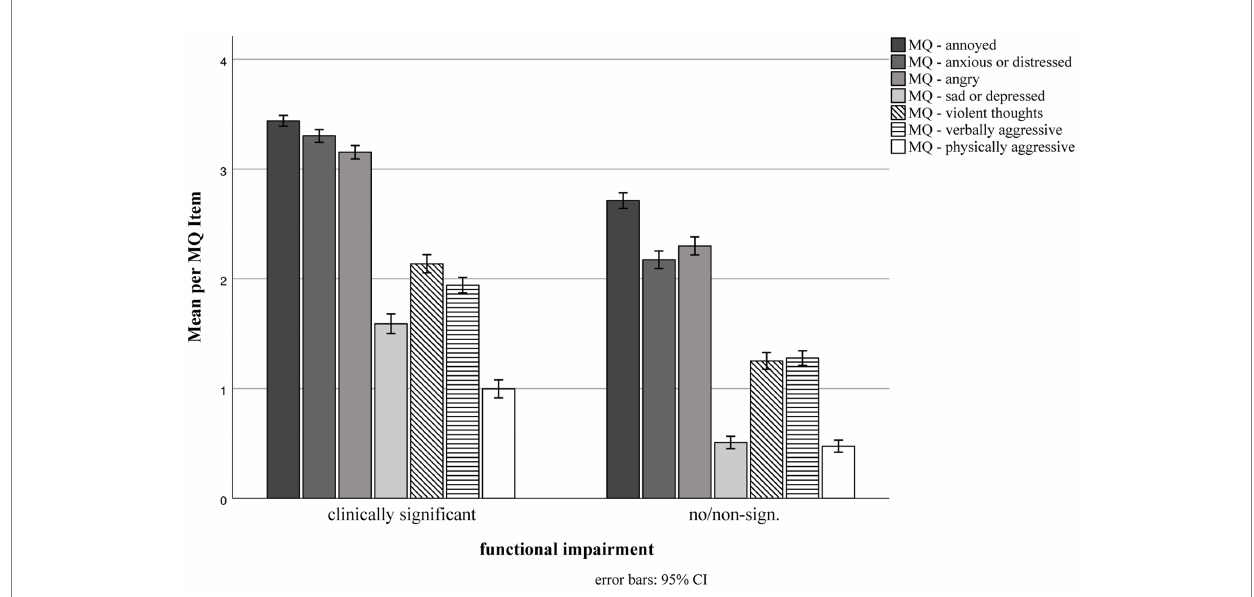
FIGURE 1 Emotional and behavioral reactions to trigger. Groups based on misophonia-specific functional impairment according to the WSAS: Work and Social Adjustment Scale. Items of the Misophonia Questionnaire (MQ) range from 0 “never” to 4 “always.” 95% CI = 95% confidence